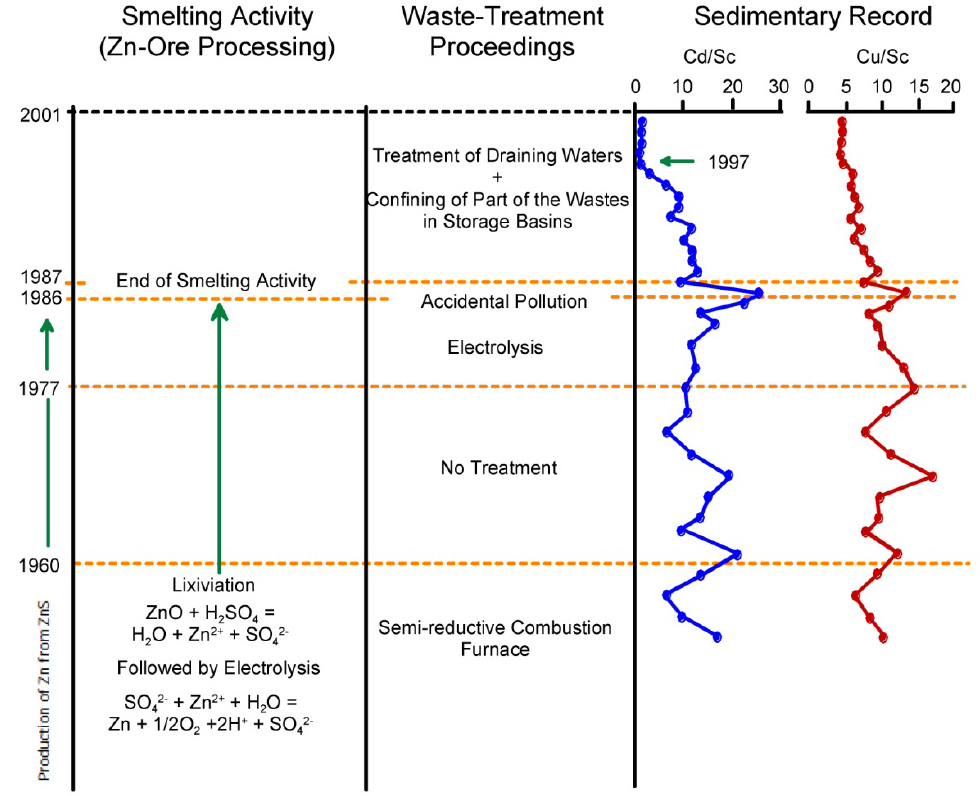
Figure 5. Vertical (depth) variations in Cd/Sc and Cu/Sc ratios within samples from a dated sediment core extracted from the Cajarc reservoir, located along the Lot River, France. Variations reflect changes in Cu and Cd influx to the river in response to alterations in processing methods and, after 1987, remediation efforts (modified from Audry et al.